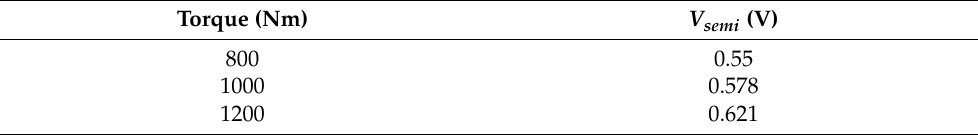
Figure 7. 𝑉 (cid:3046)(cid:3032)(cid:3040)(cid:3036) for different working conditions. Figure 7. V semi for different working